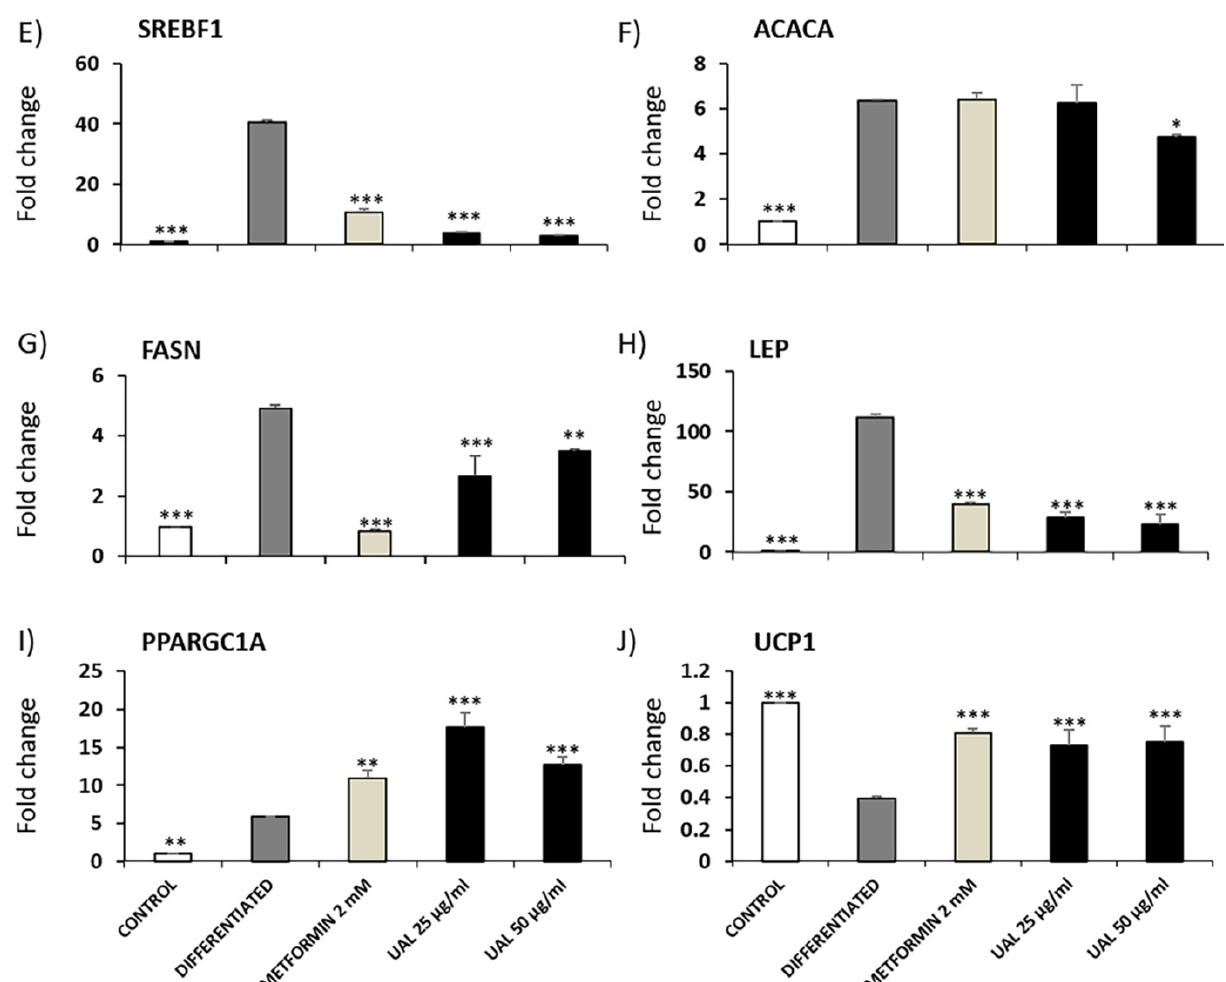
Figure 6. Effect of UAL on the expression of functional genes in 3T3-L1 cells. 3T3-L1 cells were differentiated for 4 days and treated with UAL for 24 h. Metformin was used as positive control. Relative expression of Pparg ( A ), Cebpa ( B ), Adipoq ( C ), Ppara ( D ), Srebf1 ( E ), Acaca ( F ), Fasn ( G ) Lep ( H ), Ppargc1a ( I ), Ucp1 ( J ) mRNA transcripts is shown. Values are expressed as mean ± SEM of three independent experiments. * p < 0.05, ** p < 0.01, *** p < 0.001 compared with DIFFERENTIATED (ANOVA with Dunnett´s post hoc test).